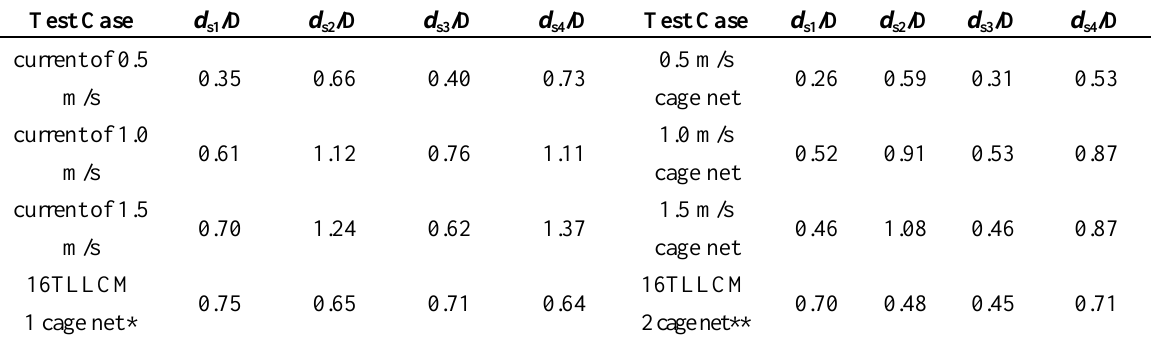
Table 4. The maximum scour depth around the four piles of the jacket-type foundation and the coastal cage net (a water depth of 16 m) under different hydrodynamic conditions (D = 2.08 m).